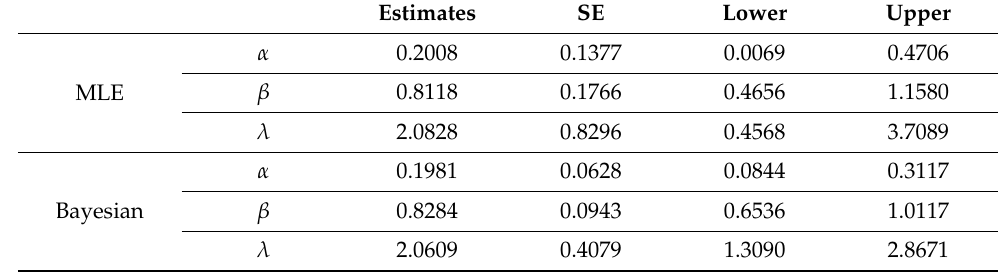
Table 5. MLE and Bayesian estimation for parameters of TIIHLW distribution. Estimates SE Lower Upper